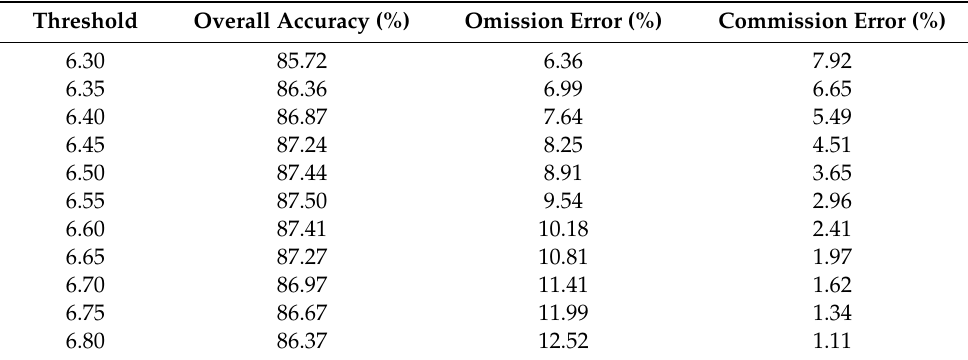
Table 3. The accuracy of area 2 with different thresholds.